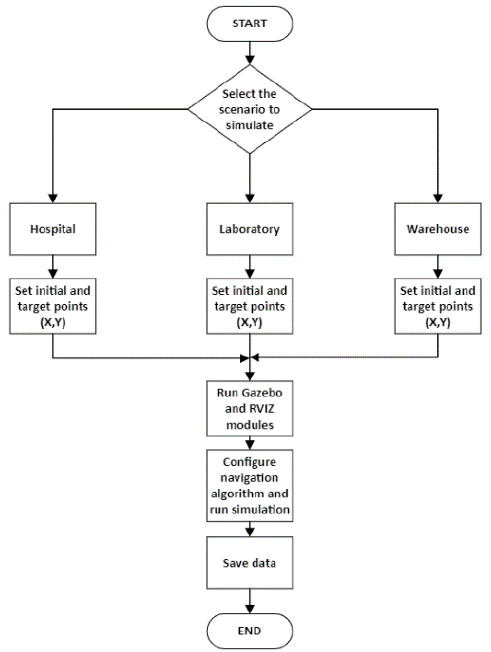
target point must be set. Finally, the users have to configure the algorithm to run.